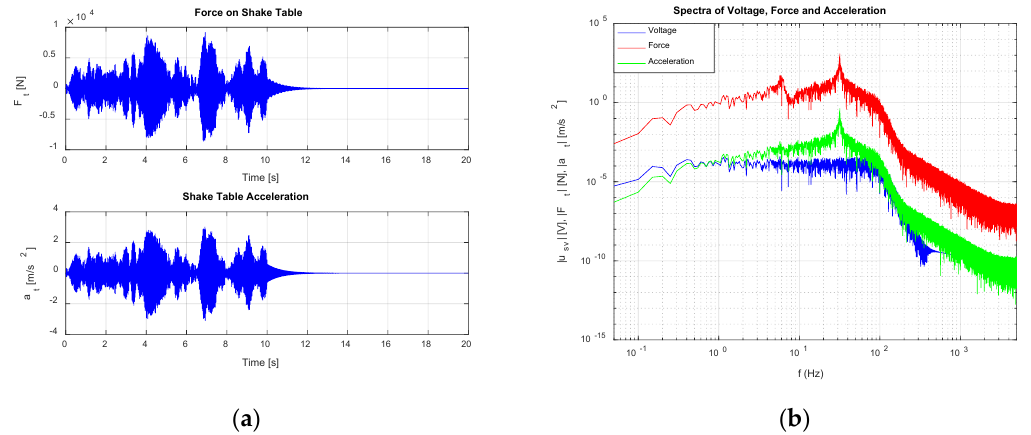
Figure 7. Identification signals (one block): ( a ) Force on table and table acceleration in time domain; ( b ) Servovalve voltage, Force on table and table acceleration in frequency domain.